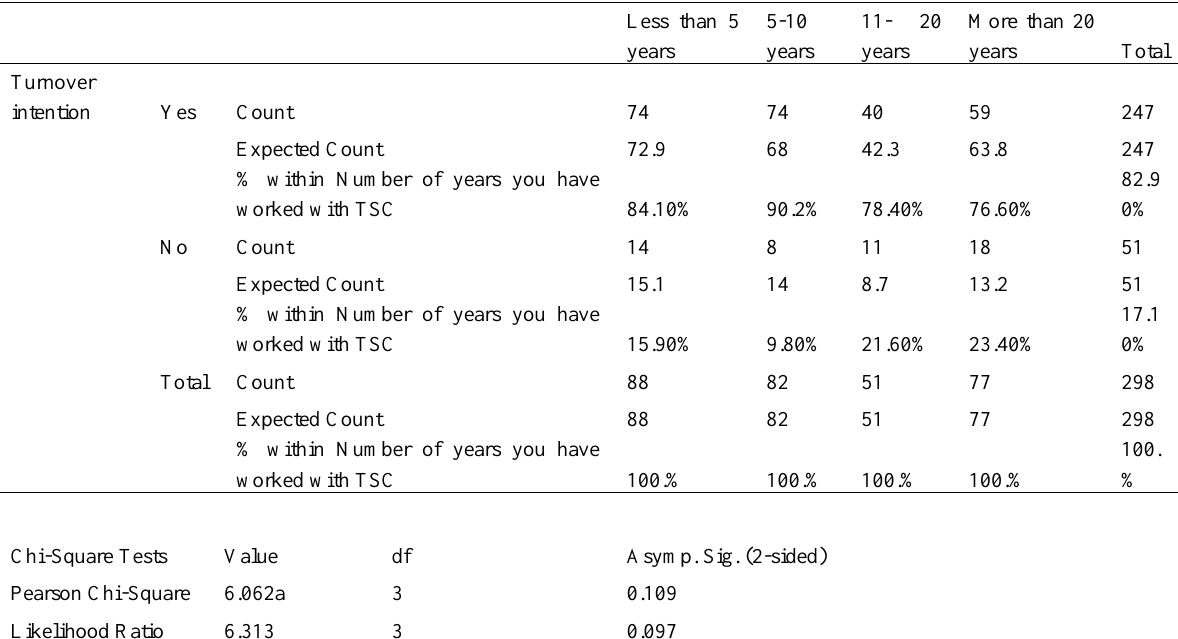
Table 6: Cross Tabulation of Turnover Intentions and